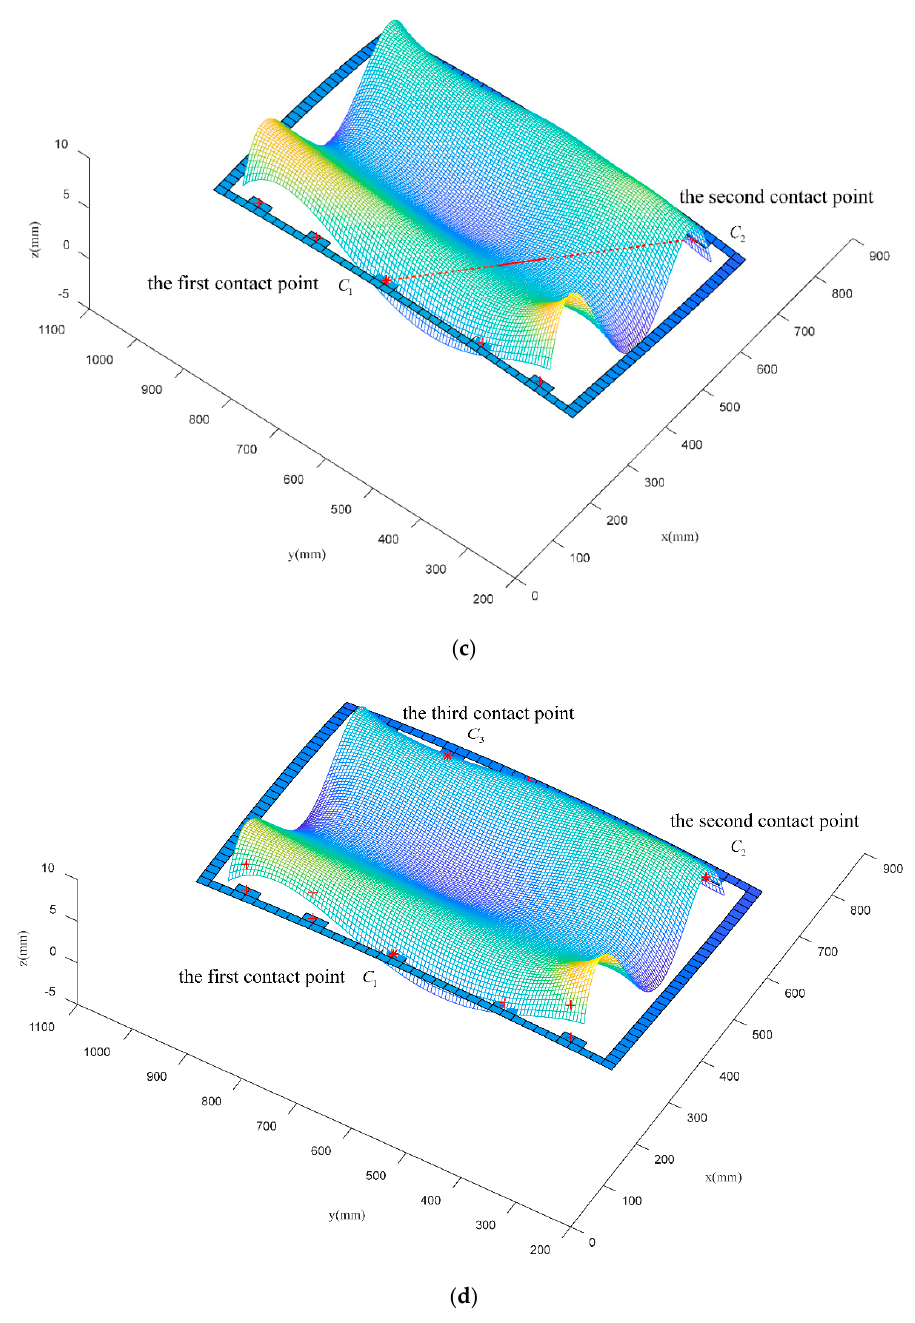
Figure 6. ( a ) The initial state of the frame and the base plate. ( b ) The first contact point and the rotation axis. ( c ) The second contact point and the second rotation axis. ( d ) Three contact points and the final state of the two parts.